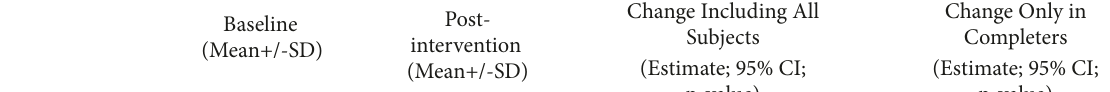
Table 3: Summary statistics for patient reported outcome